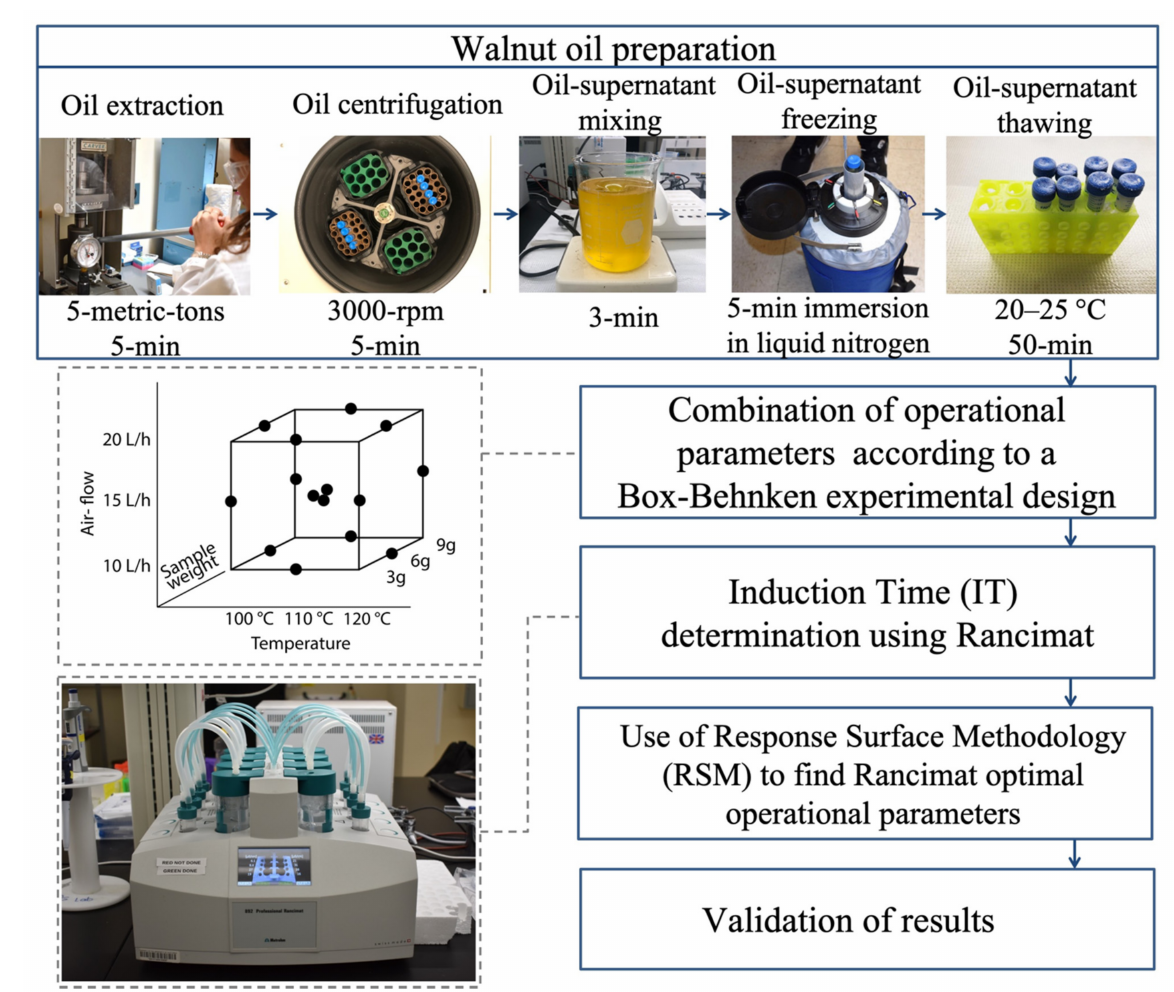
Figure 1. Description of the followed methodology to optimize Rancimat operational